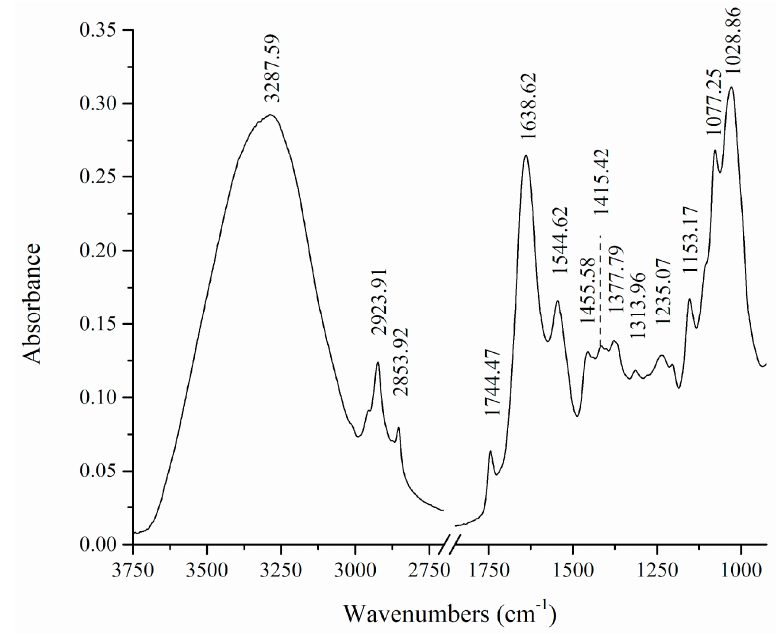
Figure 1. FTIR spectrum of untreated Trichoderma cell.